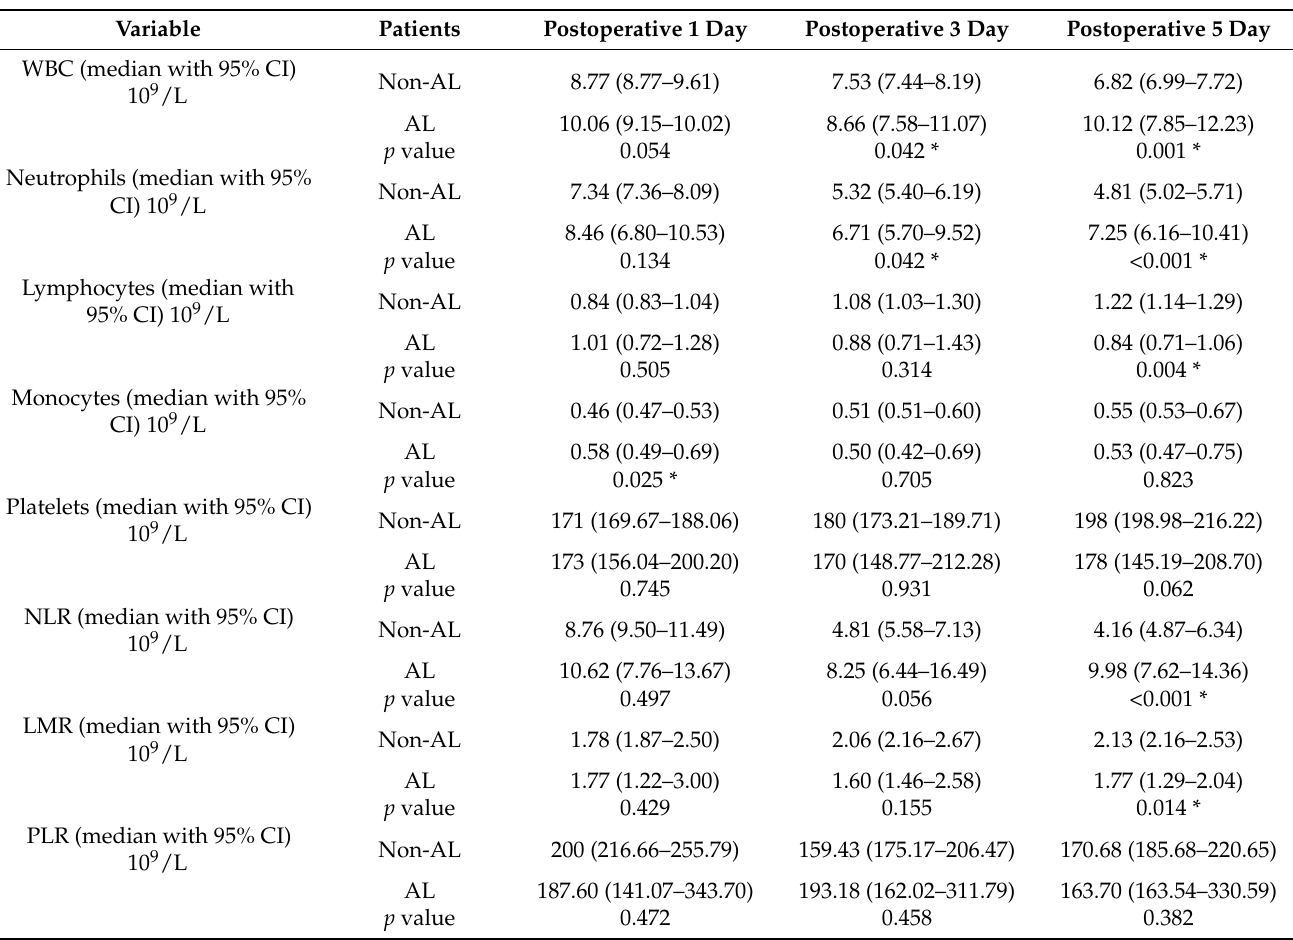
Table 2. Comparison of the mean values of the variables in patients with and without symptomatic AL before propensity score-matched